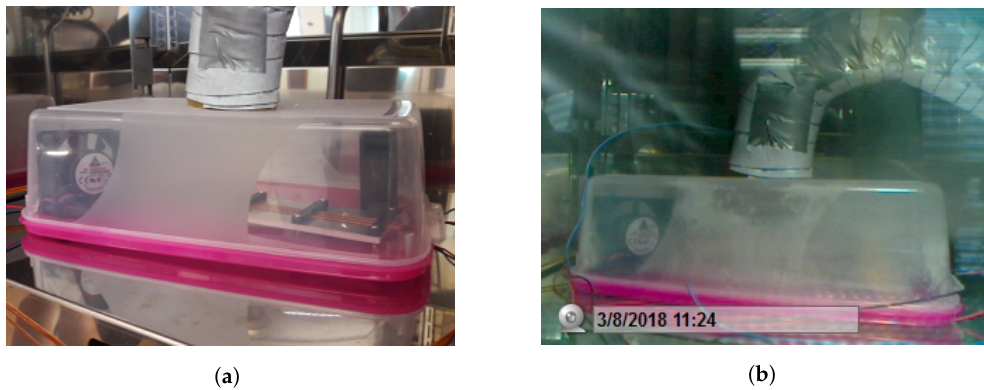
Figure 9. In ( a ), the laboratory setup for icing experiments is shown. The enclosed box is placed in the climate chamber and kept at low temperature. Ambient air with a dew point above the temperature in the chamber is blown in and the moister freezes on the cold surfaces. The hose for the air needs to be insulated in order to avoid freezing inside the hose. Fans inside the chamber are used to distribute the air (and thus the moisture) inside the box. In ( b ), an image from webcam during icing experiment is presented. Ice accretion on the surfaces of the sensor and the box can be observed.